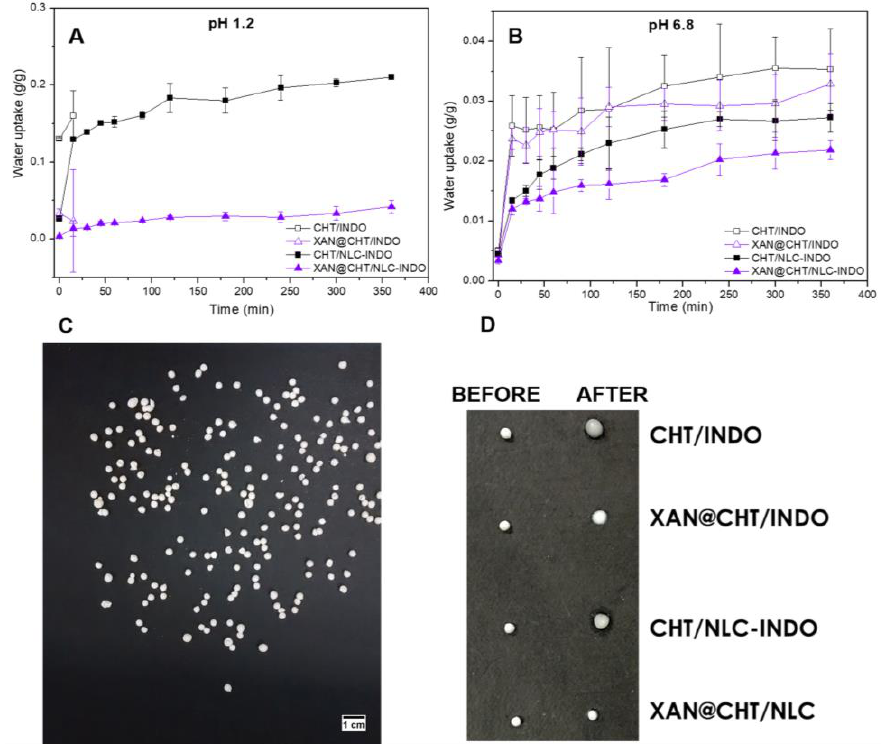
Figure 7. In vitro water uptake from beads and nanobeads in two different conditions: pH 1.2 ( A ) and pH 6.8 ( B ). Digital photos from the prepared samples ( C ) and the samples before and after the test ( D ) at pH 6.8 were provided. CHT/INDO = chitosan bead loading INDO 2% ( w / v ), XAN@CHT/INDO = xanthan-coated bead loading indomethacin 2% ( w / v ), CHT/NLC-INDO = nanobead